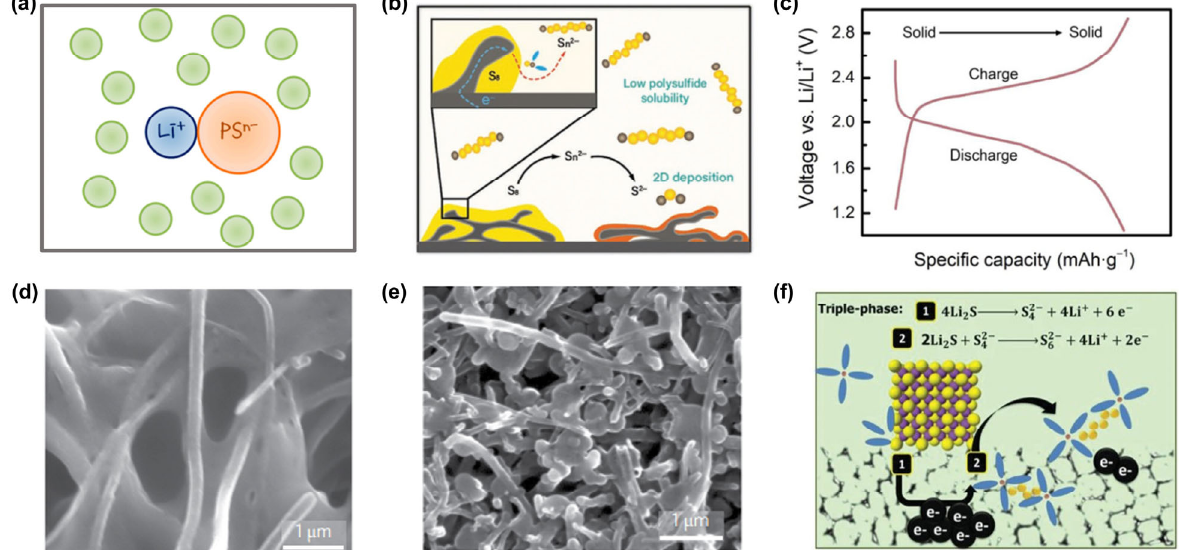
Figure 3 (a) Schematic illustration of the solvation structure, (b) electrochemical reaction mechanism, (c) charge/discharge voltage profiles, and morphologies of Li 2 S deposits in electrolytes with (d) TMS and (e) DMSO solvents. Reproduced with permissions from Ref. [68], © MDPI